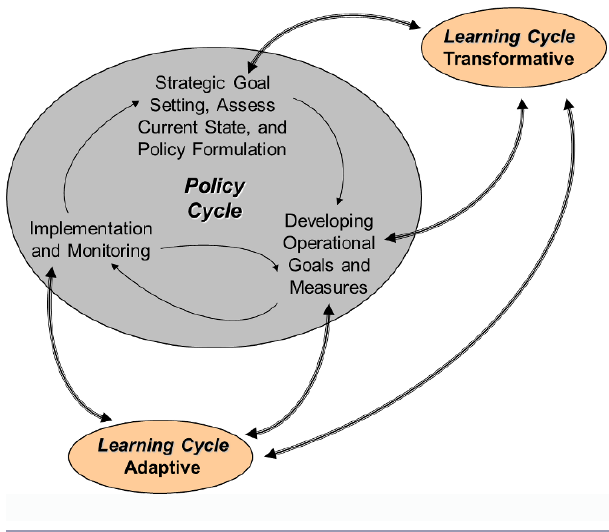
Fig. 1 . Schematic representation of links between formal policy and informal learning cycles. The policy cycle is depicted in three aggregated phases. Bold arrows denote links between learning and policy cycles. Within the formal policy cycle, learning refers mainly to single-loop learning, the incremental improvement of established